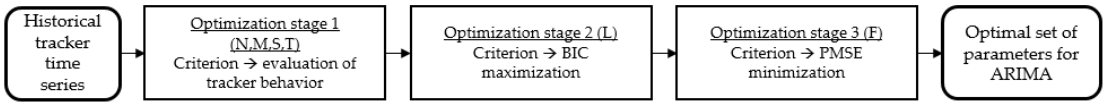
Figure 6. Procedure adopted to optimize parameters feeding the discussed algorithm.